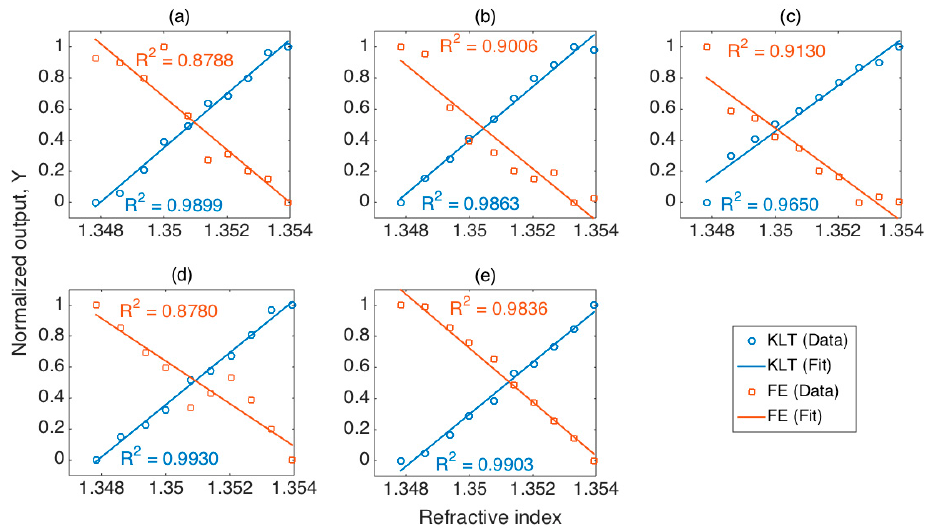
Figure 10. Comparison between KLT and feature extraction, for 5 different resonators. The charts report the normalized output Y for each method, as a function of refractive index (10 RI datapoints from 1.3478 to 1.3539). All ball resonators were fabricated using the same method based on CO 2 laser splicer, and had different diameters: ( a ) 290 μ m; ( b ) 466 μ m; ( c ) 515 μ m; ( d ) 521 μ m; ( e ) 532 μ m.